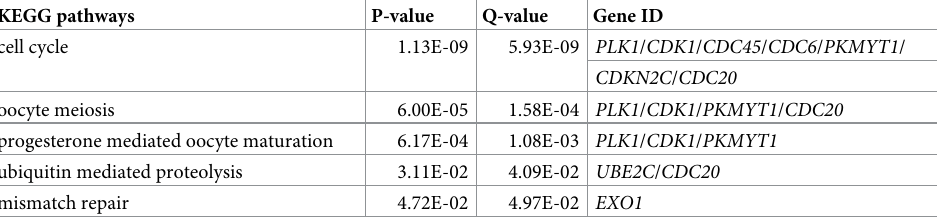
Table 3. KEGG pathways and their corresponding P-values and Q-values, and common genes enriched in their